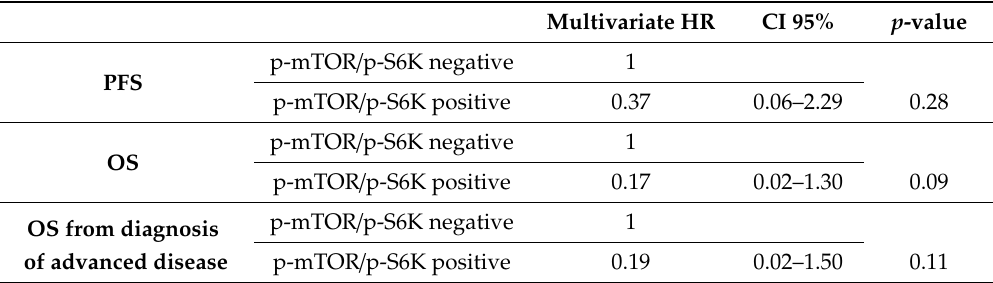
Table 3. Multivariate Cox regression